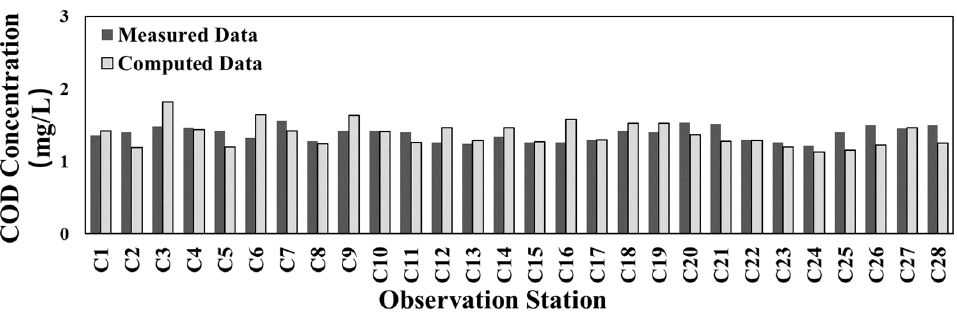
Figure 4. Comparison of computed and measured COD concentration at the 28 sampling stations.